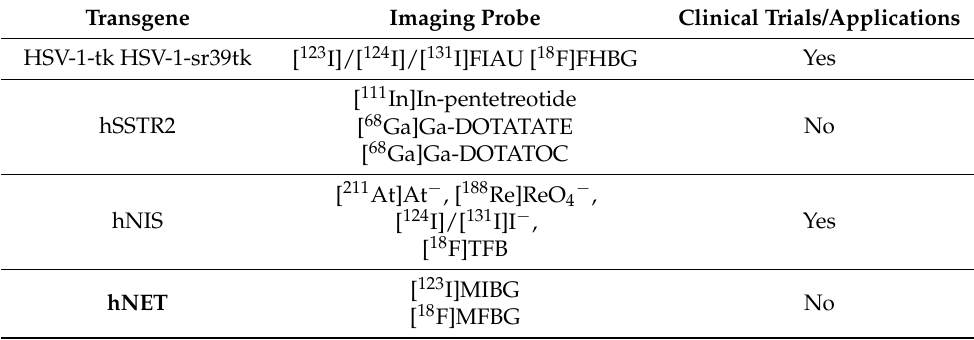
Table 2. Examples of gene reporter systems and their corresponding imaging